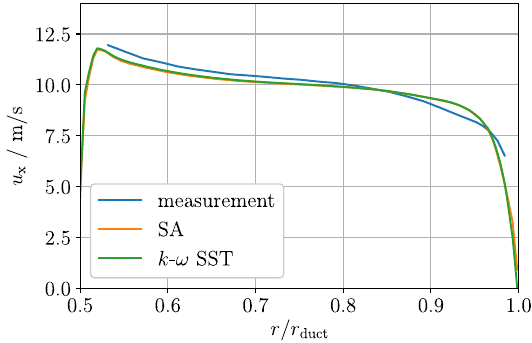
Figure 8. Time averaged velocity in axial direction on the suction side.